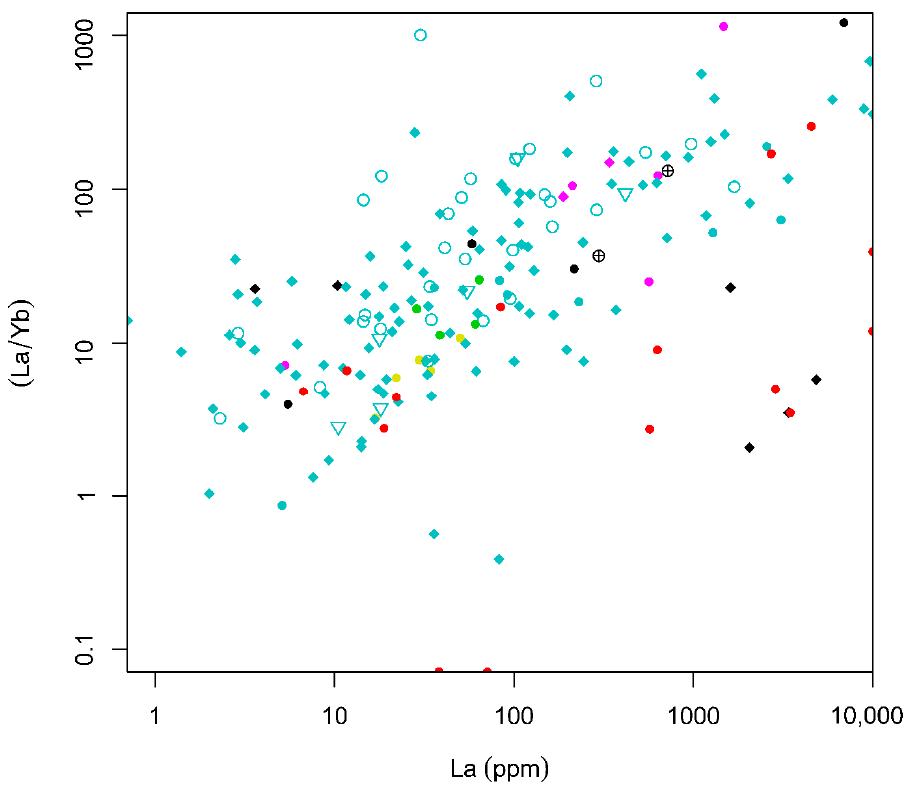
Figure 6. Bivariate plot of La (ppm) versus La/Yb for the EURARE samples (see the legend in Figure 5).